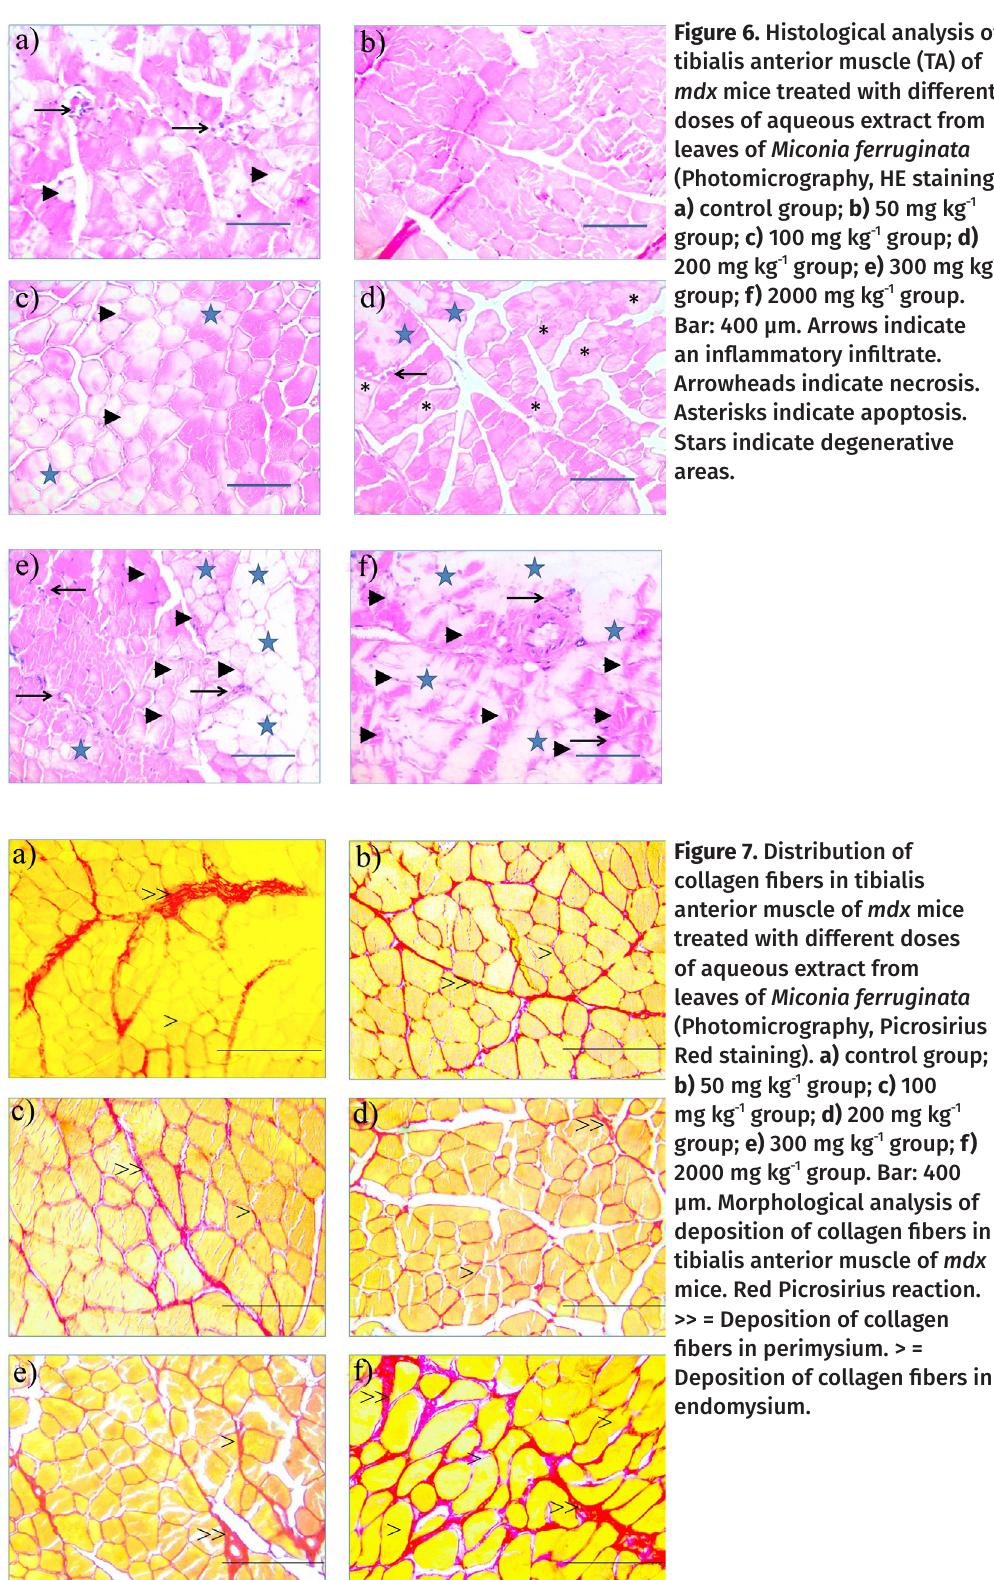
deposition of collagen fibers in tibialis anterior muscle of mdx mice. Red Picrosirius reaction. fibers in perimysium. > = Deposition of collagen fibers in endomysium.